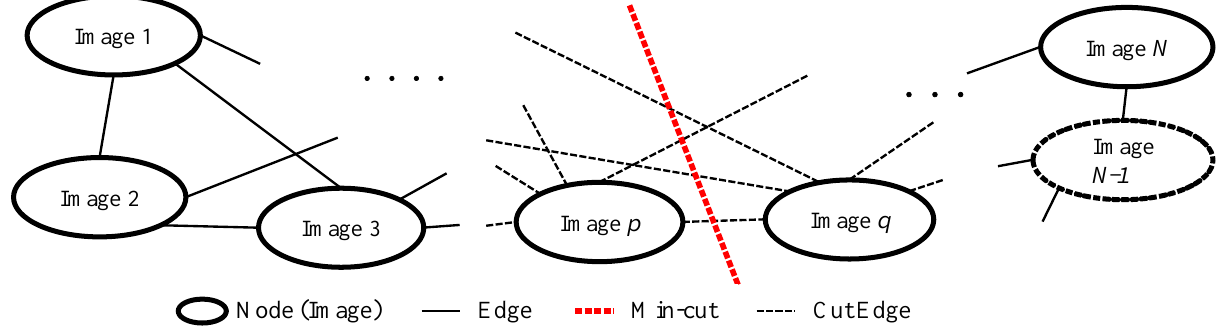
Figure 5. Graph cuts for image selection